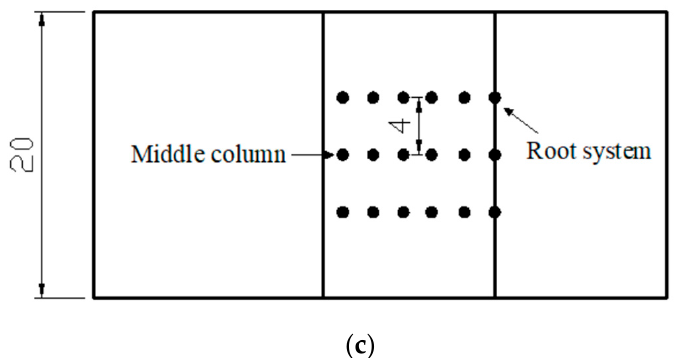
Figure 5. The Geometry of the Vegetated Slope: ( a ) Side view of the rooted slope, ( b ) 3D geometry of the slope, ( c ) Plan view of the rooted slope.